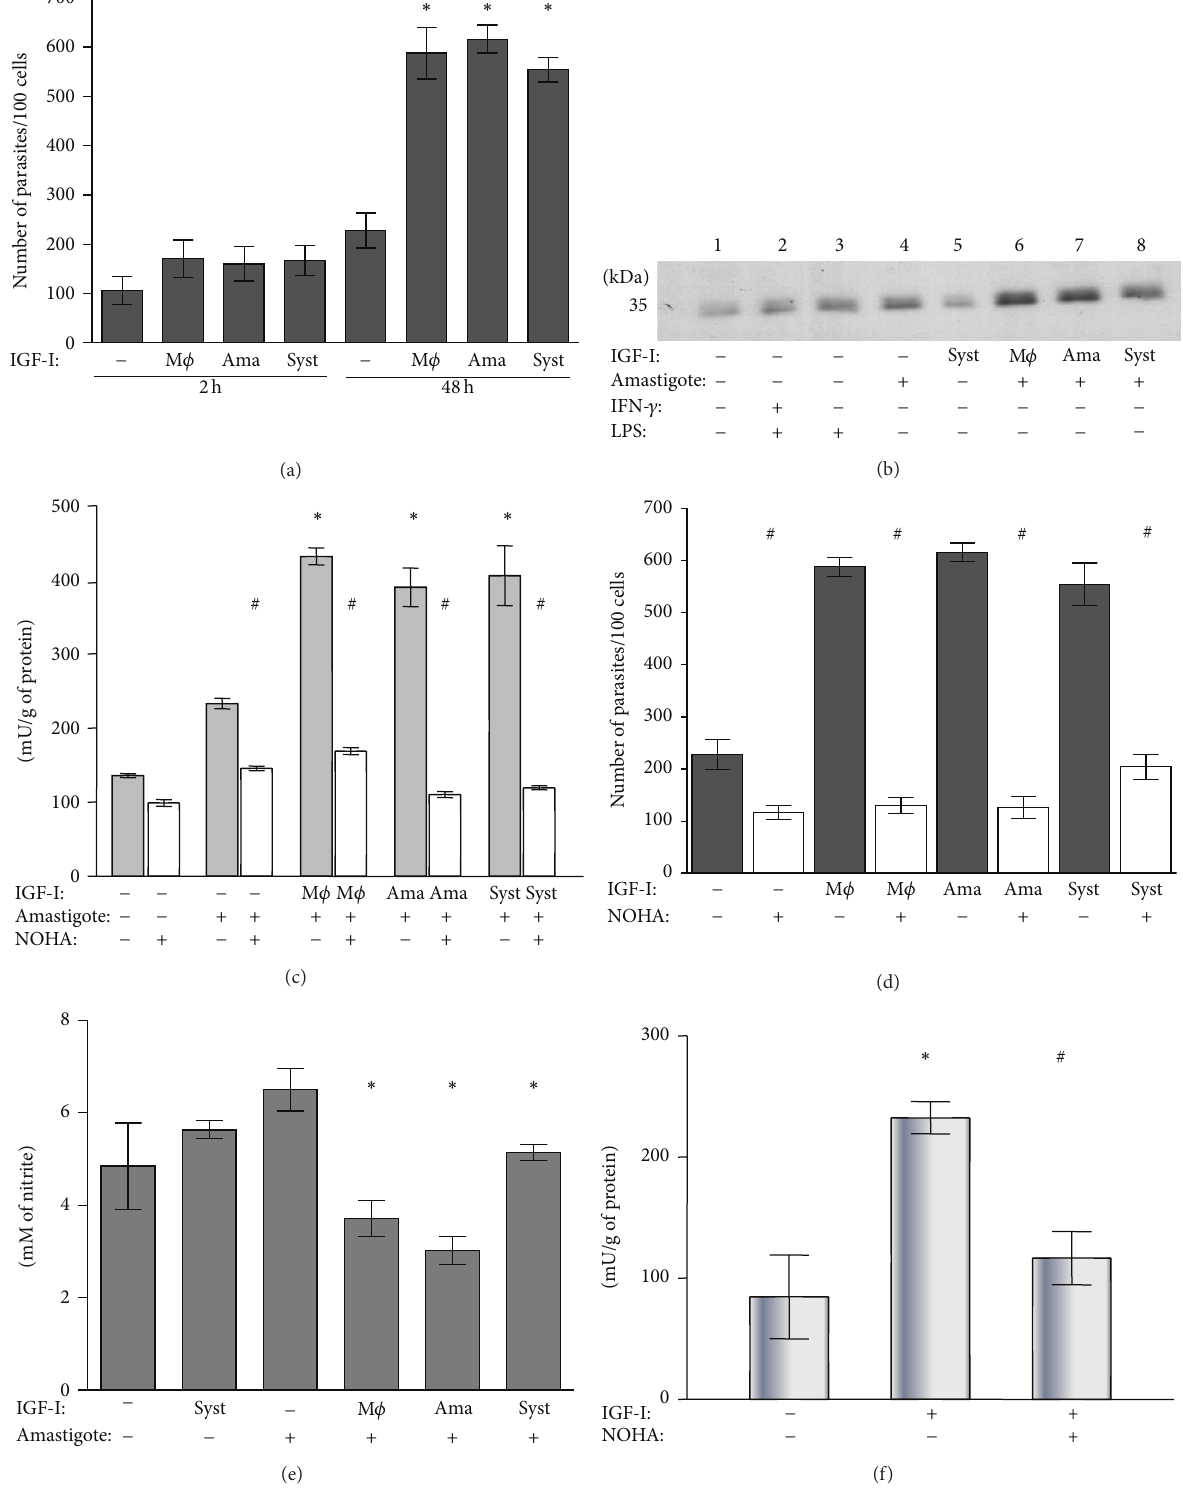
Figure 1: Effect of IGF-I on the Leishmania amastigote-macrophage interaction. ( a) Parasite burden evaluated after 2 and 48 h of culture. (b) Arginase expression analyzed in infected macrophages at 24 h with western blotting using an anti-arginase-I antibody. (c) Arginase activity evaluated in the interaction measuring urea production with and without the arginase inhibitor NOHA. (d) Effect of inhibition by NOHA on the parasite burden in Leishmania amastigote-infected macrophages. (e) Measurement of nitrite production in the culture supernatant by the Griess method. (f) Effect of IGF-I on the arginase activity of Leishmania amastigotes. BALB/c peritoneal macrophages were infected with amastigotes of Leishmania (L.) amazonensis. Amastigotes (ama) or macrophages (m 𝜙 ) were prestimulated for 5 min with IGF-I (50ng/mL) before interaction or the factors were maintained in the culture system (syst) throughout the experiment period. For further details see Material and Methods Section. ∗ 𝑃 < 0.05 compared with amastigote-infected macrophage without IGF-I stimulation (ANOVA and Student Newman-Keuls tests). # 𝑃 < 0.05 compared with culture without NOHA (ANOVA and Student Newman-Keuls